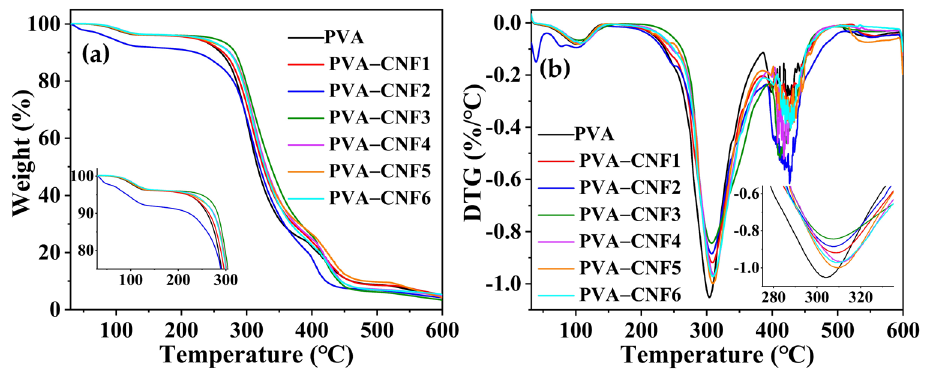
Figure 3. The TG ( a ) and DTG ( b ) curves of the pure PVA and composite films.